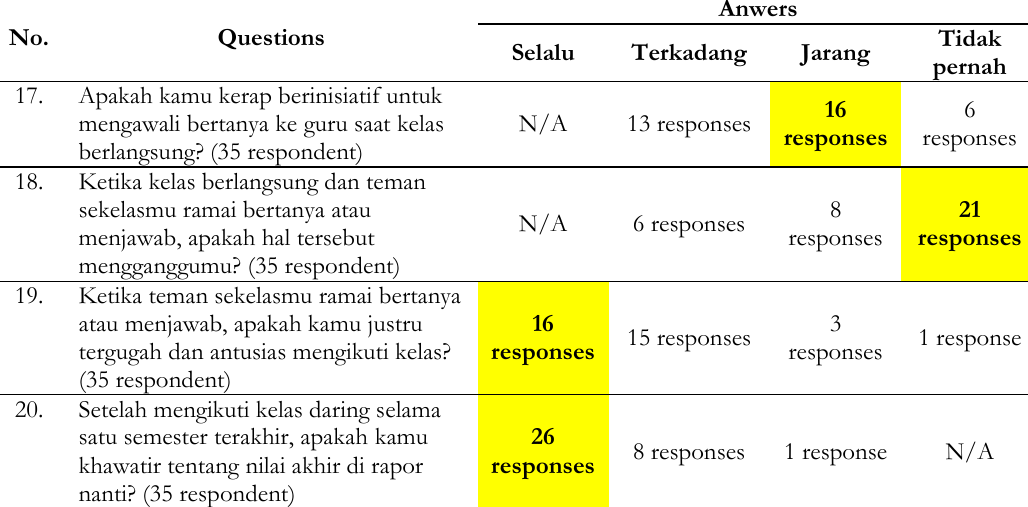
TABLE 5. The 4 th Topic of the